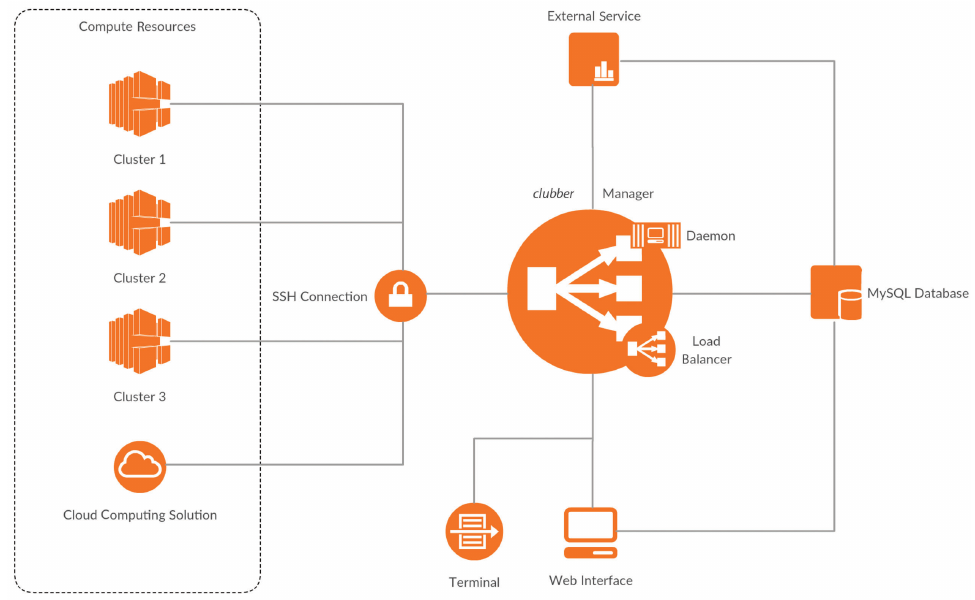
Figure 1: The clubber pipeline. Jobs can be submitted either through a web interface or via command-line to the clubber manager. These are registered and managed using a relational database. The manager uses an automated balancing ap- proach to distribute jobs among available clusters; the manager daemon runs locally and communicates with available clusters, transferring completed job results and storing them locally or, optionally, in the